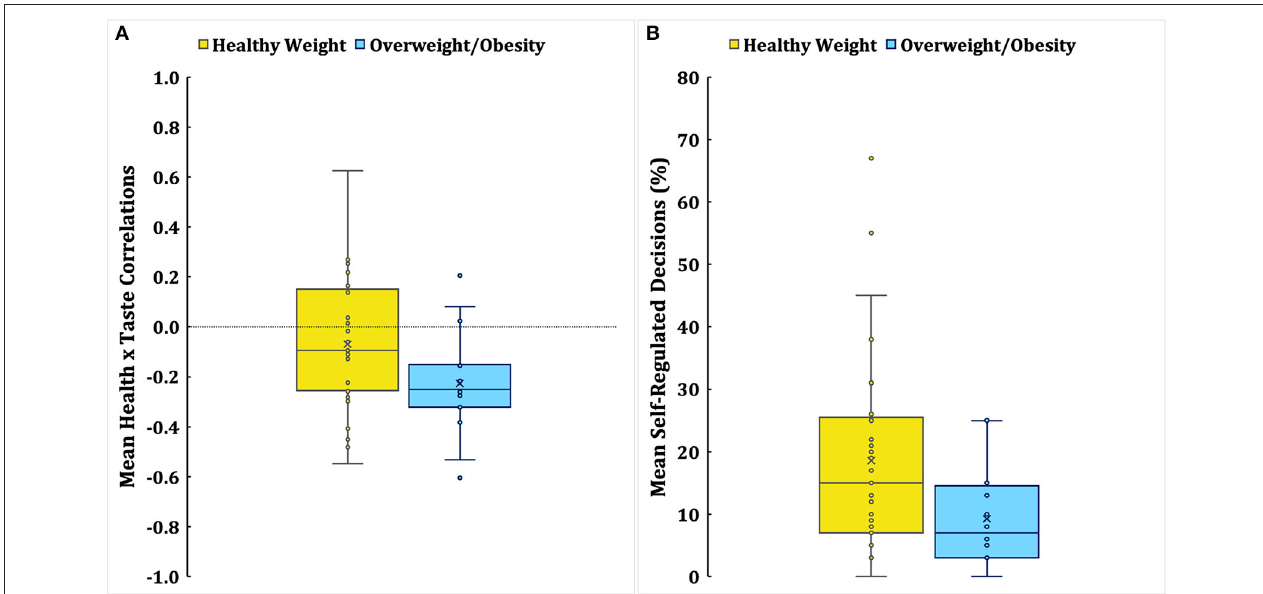
FIGURE 2 | Mean correlations between health and taste ratings ( A ) and percentages of self-regulated decisions ( B ) in children by weight status. An X mark indicates the mean, and a horizontal line within a box indicates the median. The dotted line in (A) illustrates the zero correlation